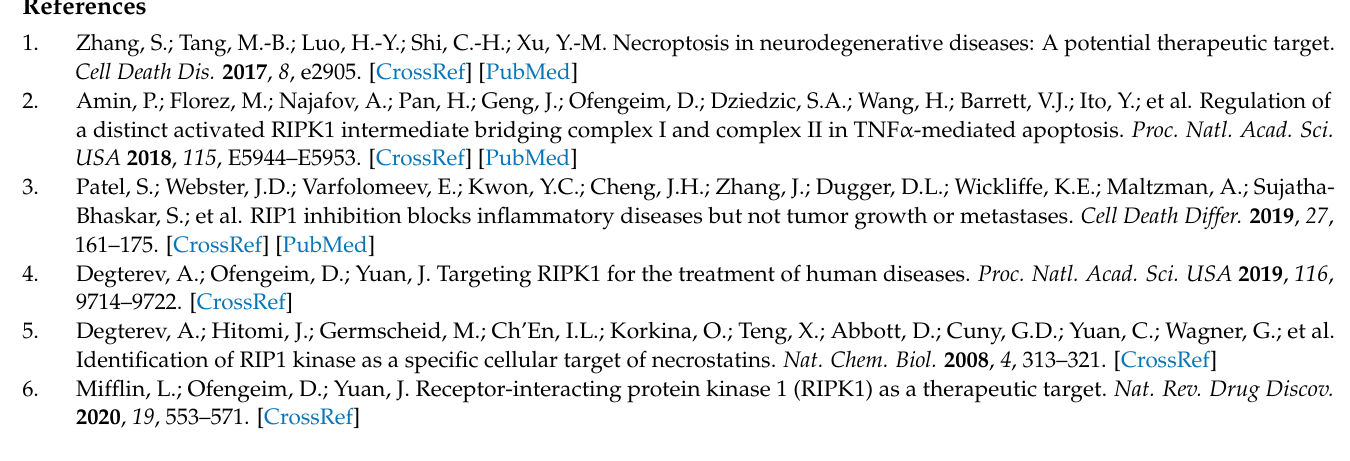
for Structure-Activity pairs are turned to the end of the allosteric back pocket in RIPK1 (see Figure S15); Figure S18. SARs involving compound 59553984. The core identified for the Structure-Activity pair is turned to the end of the allosteric back pocket in RIPK1 (see Figure S15); Figure S19. SARs involving compound 50707244. The core identified for Structure-Activity pair is turned to the end of the allosteric back pocket in RIPK1 (see Figure S15); Figure S20. Co-crystal ligand (cyan) and most active in silico hit 24920823 (green) docked in the allosteric back pocket of RIPK1